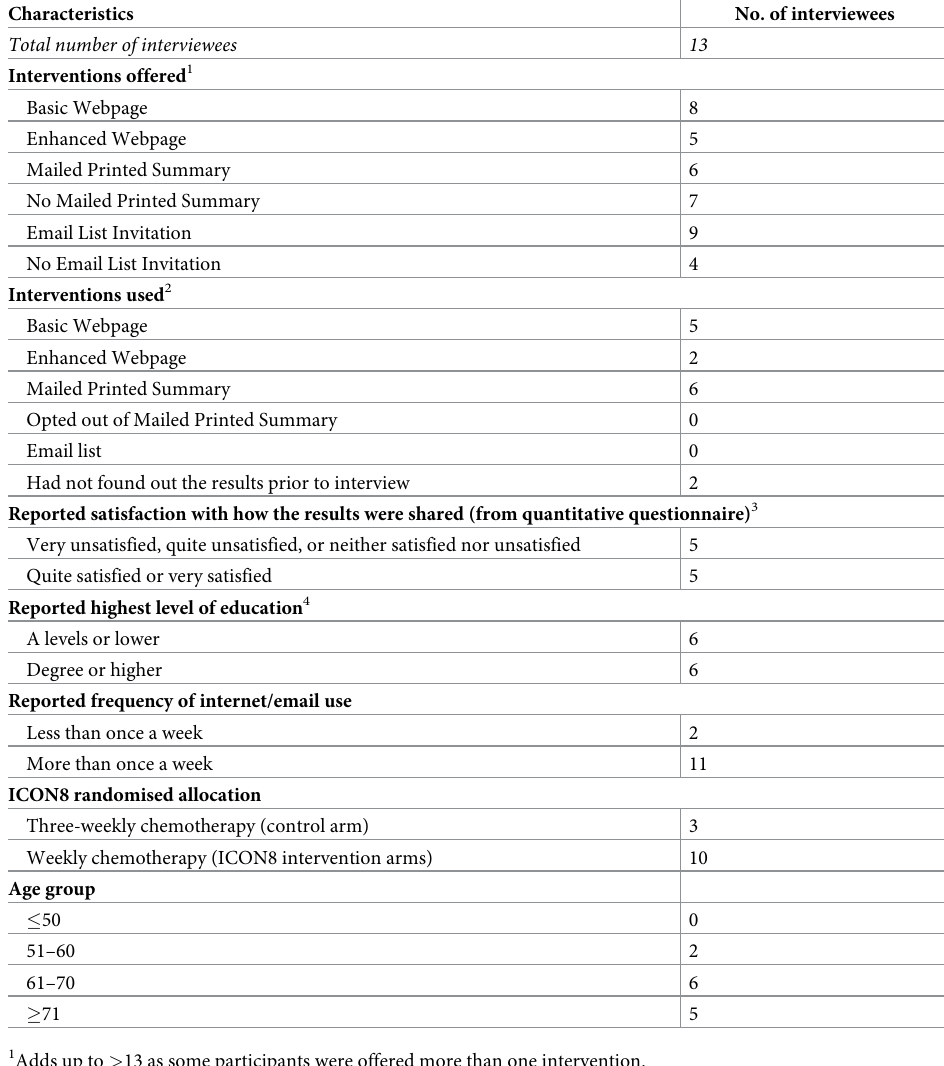
Table 3. Characteristics of qualitative